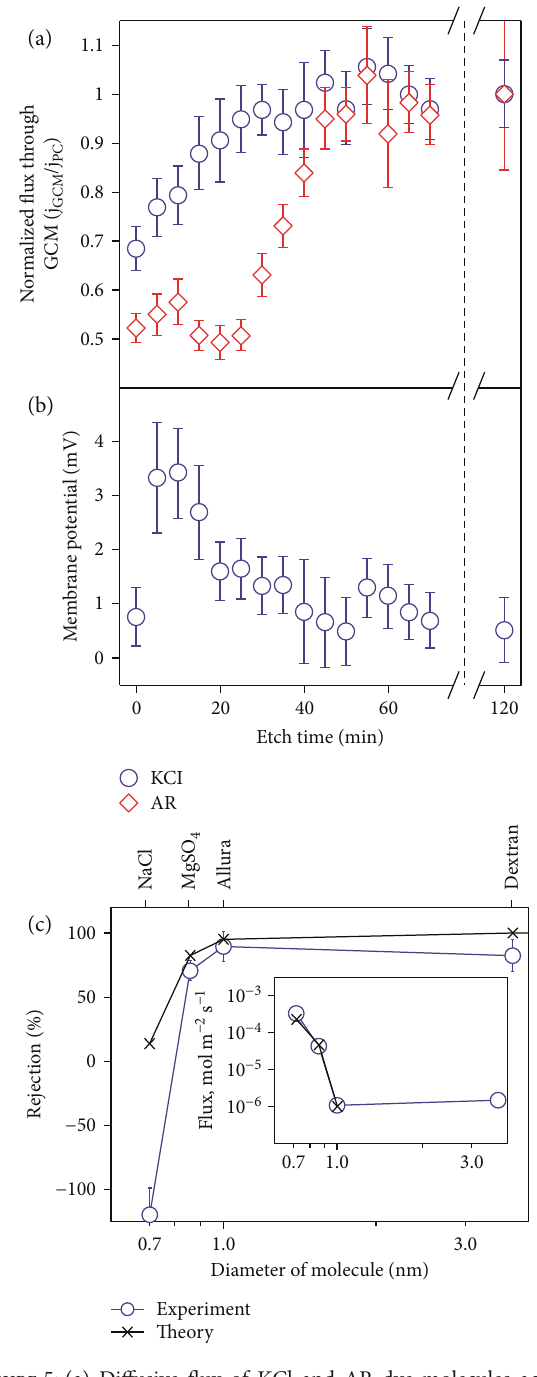
Figure 5: (a) Di ff usive fl ux of KCl and AR dye molecules across the NPG membrane with subnanometer-sized pores. (b) NPG membrane potential measurements. Reprinted with permission from [47]. (c) Experimentally measured rejection and molar fl ux (inset) of the four di ff erent solutes tested across the NPG membranes. Reprinted with permission from